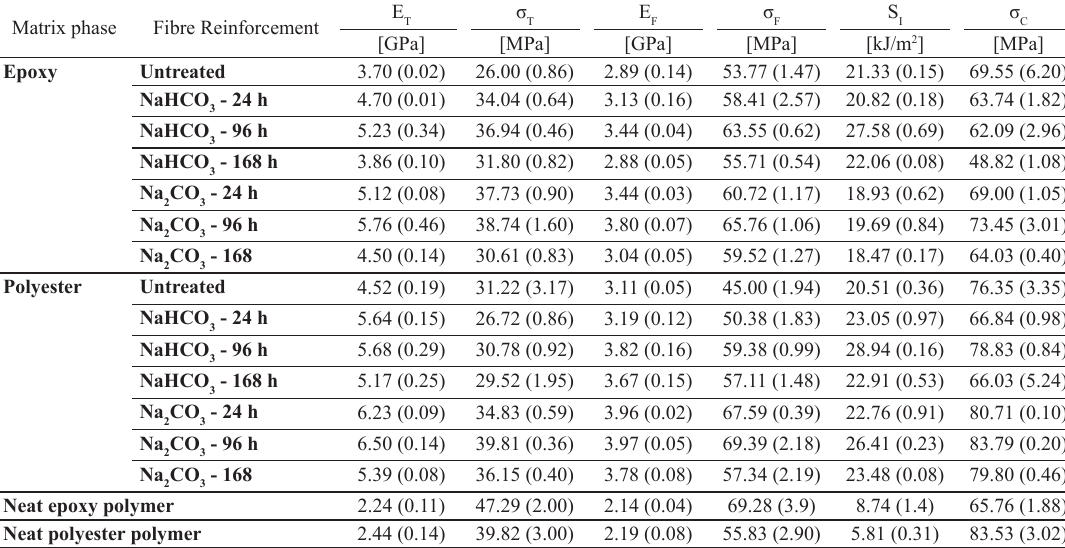
Table 3. Mechanical properties of polymers and sisal based -epoxy and -polyester composites. The standard deviation is presented in parentheses. Matrix phase